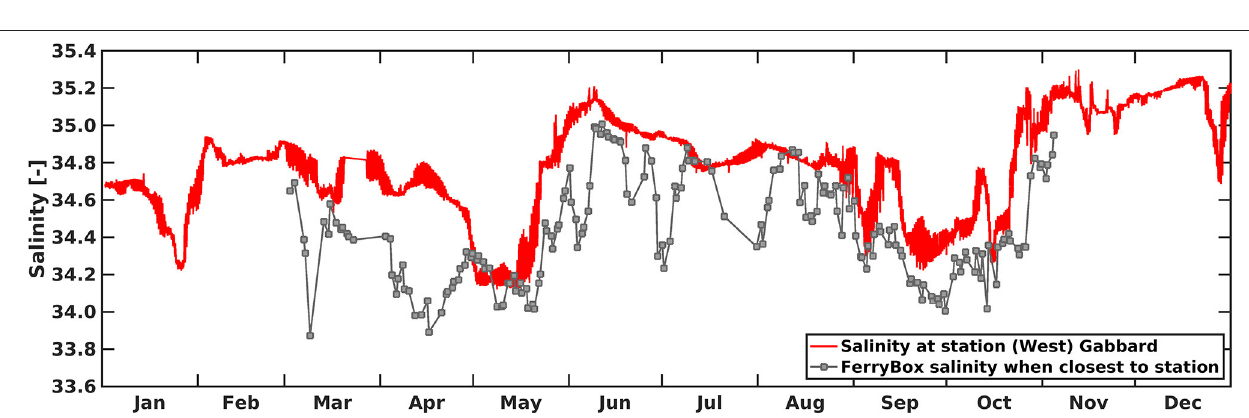
FIGURE 6 | Red: Salinity values observed at station Gabbard in the year 2002. Small gray circles represent corresponding FerryBox measurements each time the ferry was closest to the stationary buoy (cf. Figure 1